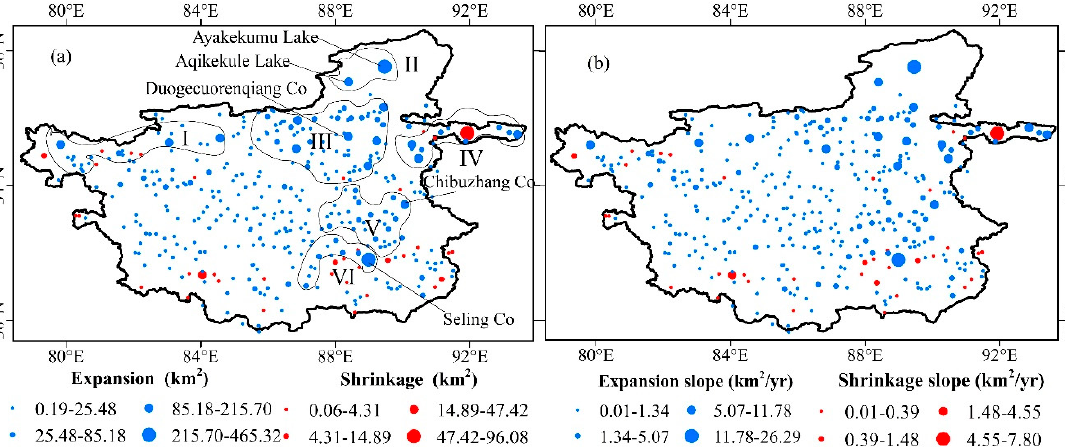
Figure 2. Annual change in total lake area in the endorheic basin from 2000 to 2017.